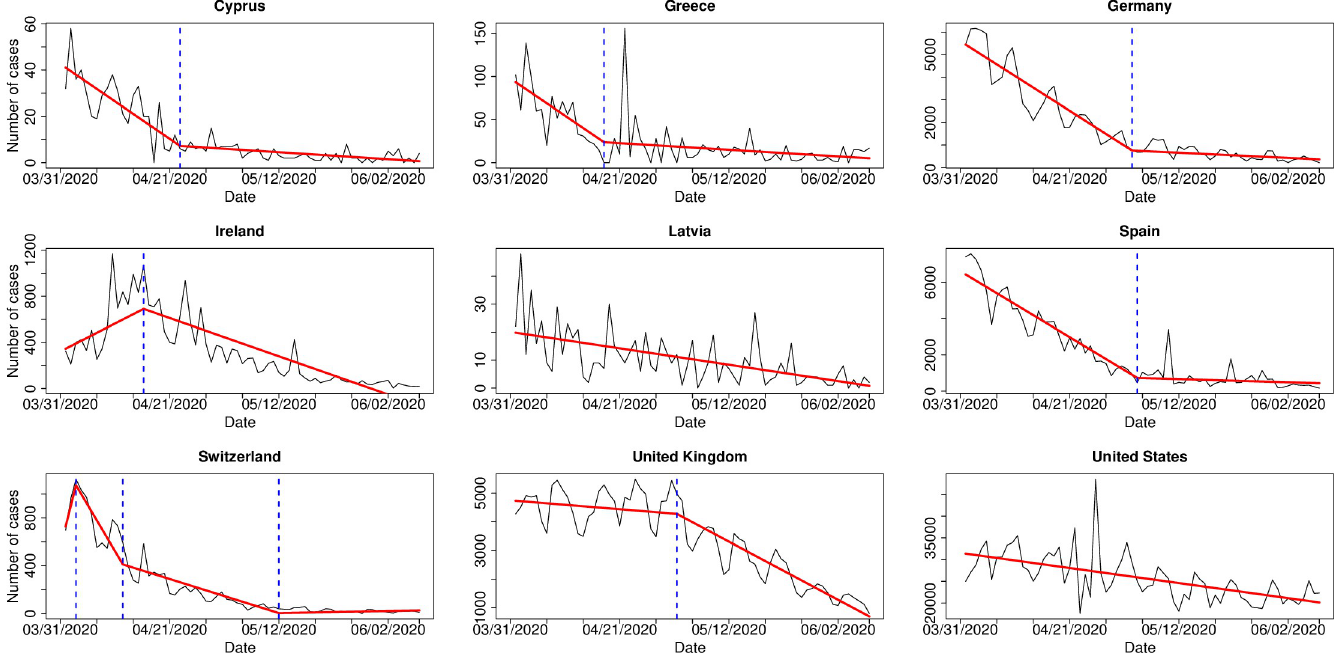
Fig 3. The real data (black colored line) and the estimated continuous, piecewise-linear signal (red colored line) for the daily number of COVID-19 confirmed cases in nine countries. The change-point locations are given with dotted, blue vertical lines.